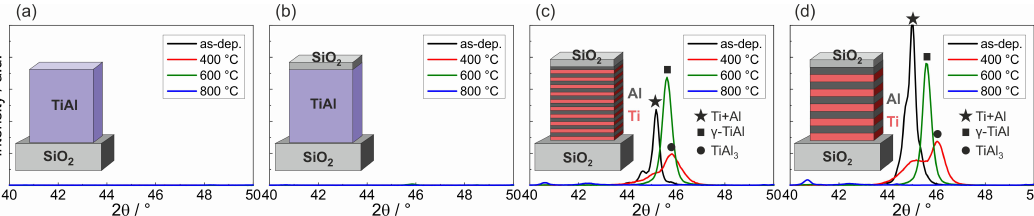
Figure 1. XRD measurements on: ( a ) a co-sputtered Ti-Al film; ( b ) a co-sputtered Ti-Al film with SiO 2 cover layer; ( c ) a Ti/Al ML film with 10 nm individual layer thickness; and ( d ) a Ti/Al ML film with 20 nm individual layer thickness, both with SiO 2 cover